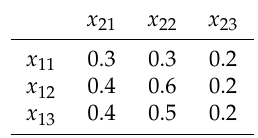
Table 3. Min-composition of the functions in Table